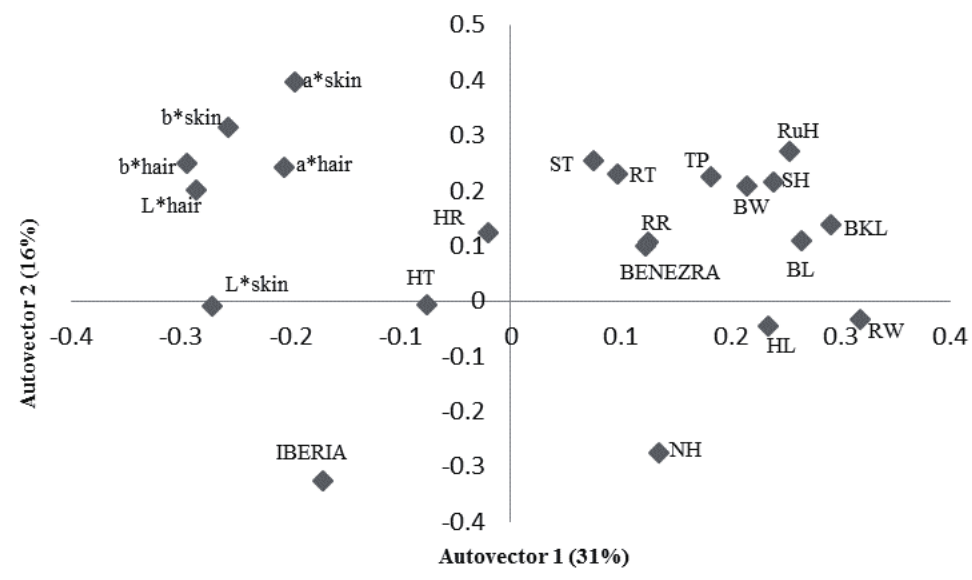
Figure 1. First two autovectors for heat tolerance indices and physiological and physical traits in sheep in the Federal District, Brazil. RT, rectal temperature (°C); HR, heart rate (beats/ min); RR, respiratory rate (movements/min); SH, shoulder height; TP, thoracic perimeter; BKL, back length; BL, body length; RuH, rump height; RW, rump width; BW, breast width; ST, skin thickness; HT, hair thickness; NH, number of hairs; HL, length of hair; L * , brightness; chromatic channels representing b * , yellow-blue; a * , red-green